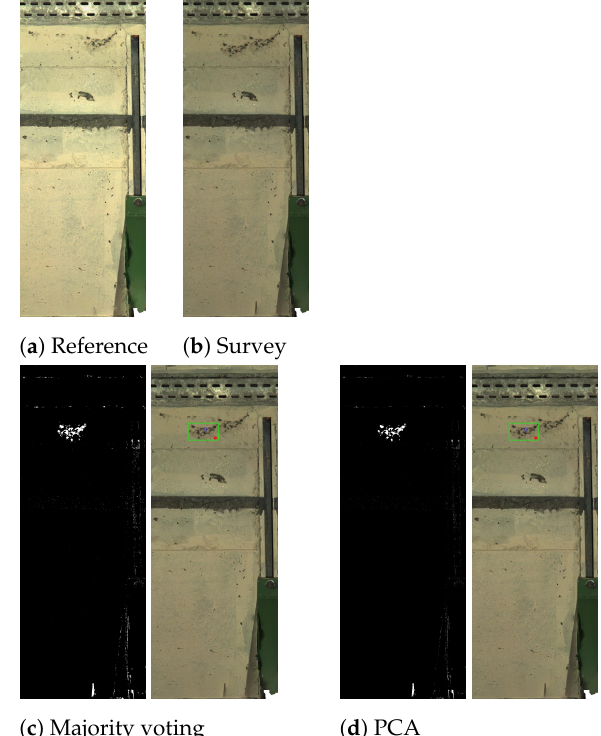
Figure 20. An example showing similar performance of majority voting and PCA solutions on a different simulated defect on the wall. Reference ( a ), survey ( b ), majority voting ( c ) and PCA ( d